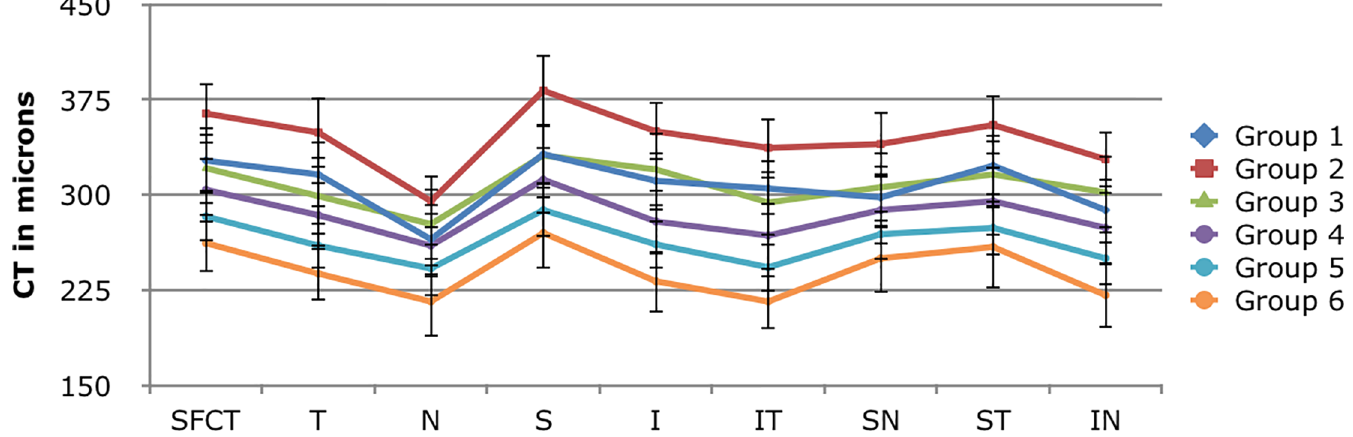
Fig 2. Graph showing choroidal thickness profile with mean and confidence interval among different age groups.